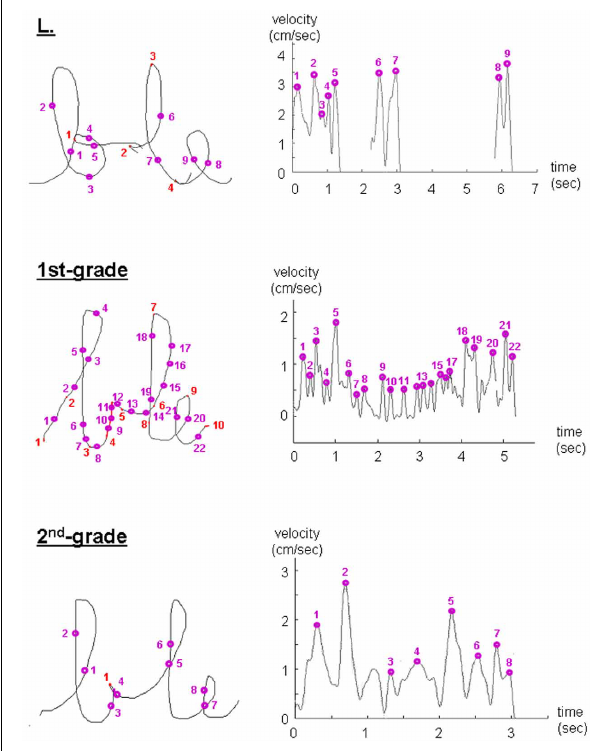
FIGURE 3 | Examples of the kinematic features of the trigram “ble” written by the child with DCD (L.) and a random first- and second-grader. The position of slow moves (red) and velocity peaks (purple circles) are shown on the letter tracks ( right panels ). On the left are shown the corresponding velocity